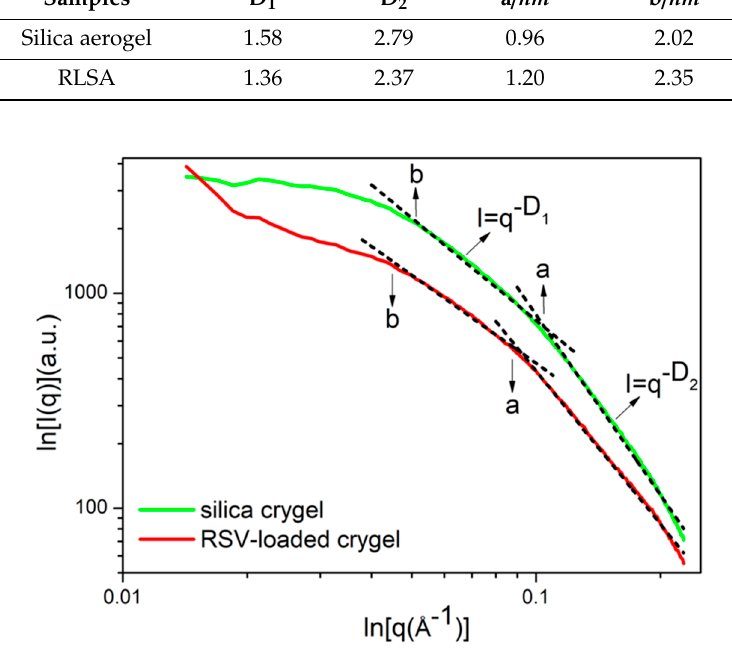
Figure 3. The small-angle X-ray scattering (SAXS) image of silica aerogel and RLSA, respectively. Table 1. Fitting results of SAXS